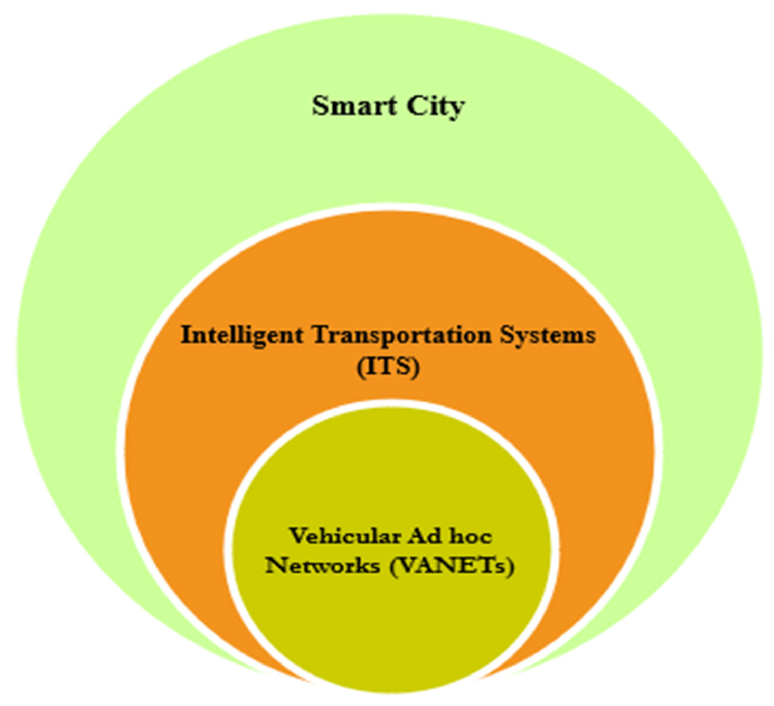
Figure 1. Components of a Smart City.